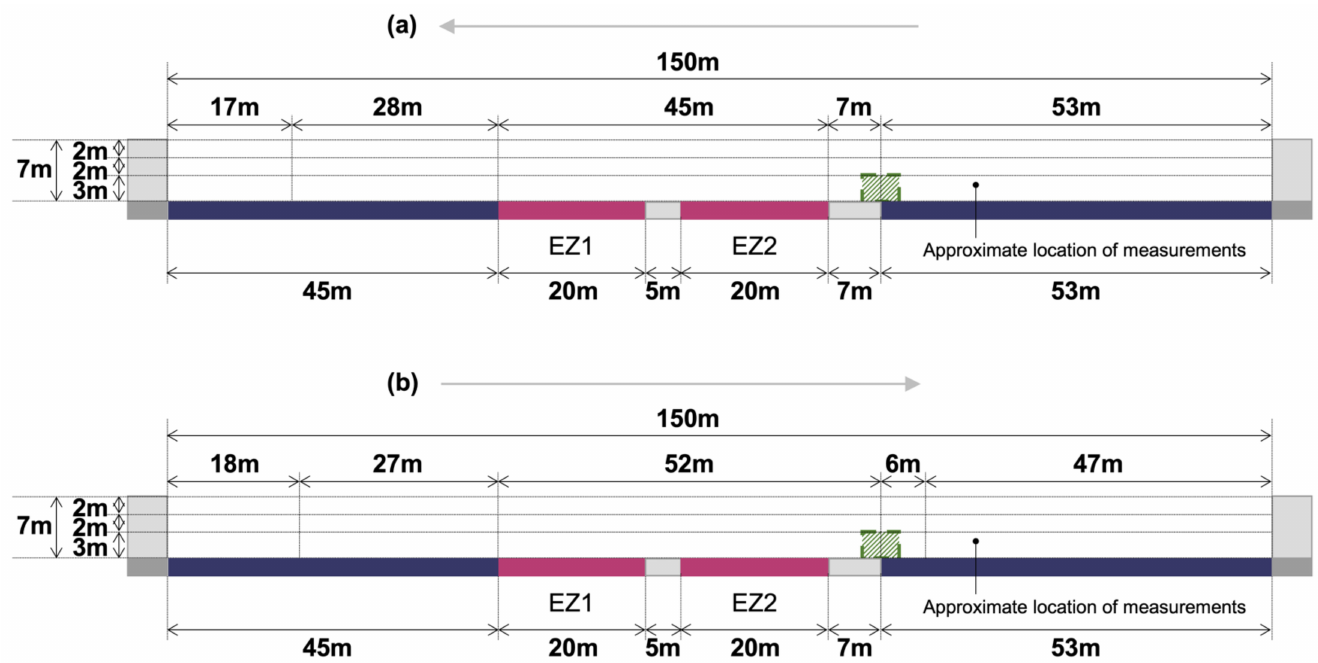
Figure 8. Street section dimensions and model grids adopted in our simulation of the differences between NO 2 concentra- tions measured behind a line of bushes, and in an adjacent clearing, beside Interstate-280 [50] when the barrier is positioned ( a ) upwind or ( b ) downwind with respect to the wind aloft; also illustrated are emission zones, EZ1 and EZ2, and the approximate location of the